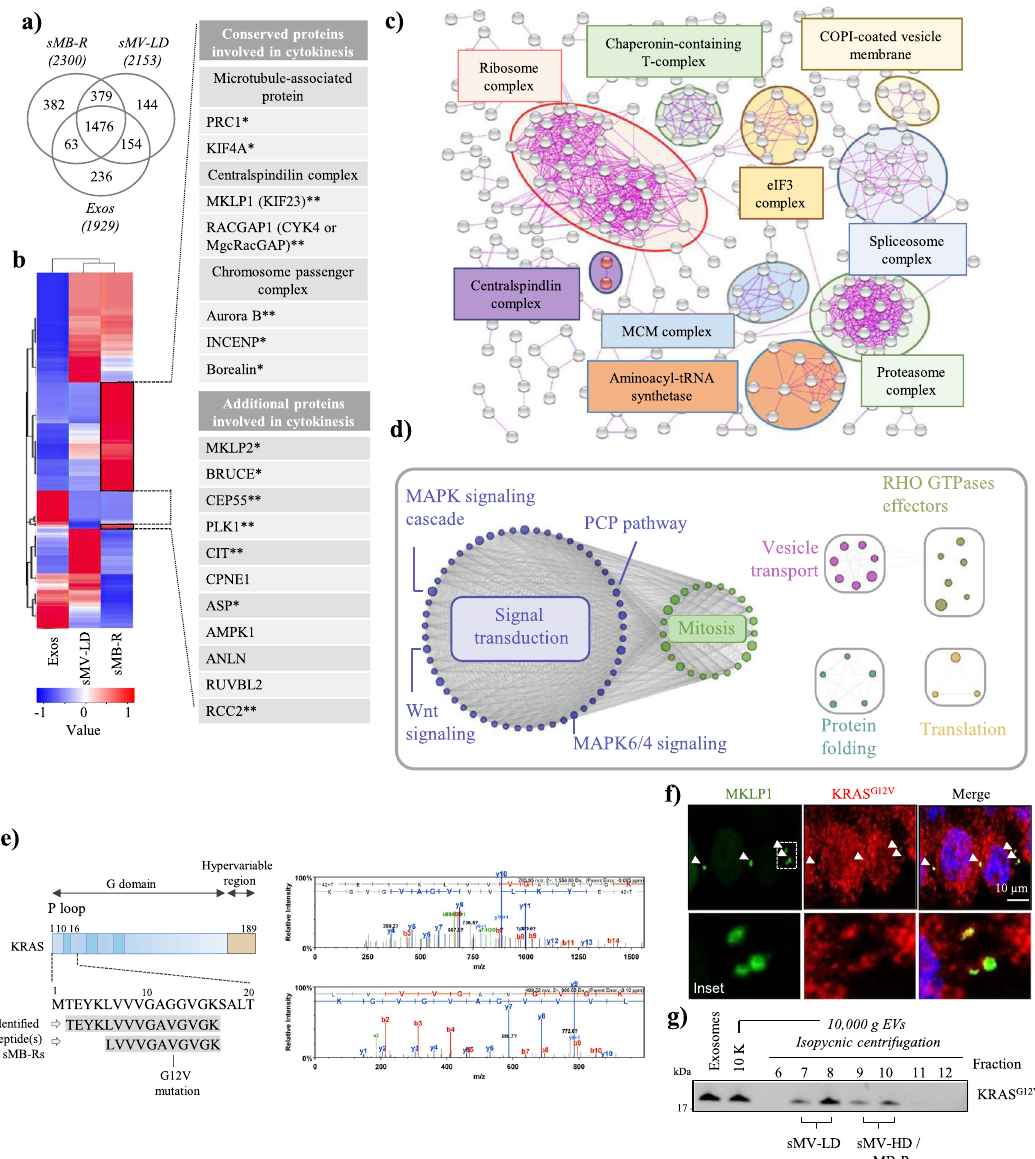
Fig. 3 Proteome analysis of shed midbody remnants. a Venn diagram of proteins identi fi ed in SW620 cell-derived sMB-R (sMV-HD), sMV-LD and Exos. b Heatmap illustration of proteins identi fi ed in sMB-R (sMV-HD), sMV-LD and Exos. Proteins present in higher abundance in sMB-R (red) as compared to sMV-LD and Exos include conserved cytokinetic proteins as well as additional cytokinetic proteins. *Proteins uniquely identi fi ed in sMB-Rs. **Proteins enriched (fold change >2) in sMB-R compared to sMV-LD and Exos. c STRING-based protein-protein interaction network analysis of 928 enriched proteins in sMB-Rs (sMV-HD) compared to sMV-LD and Exos. The interactions were “ evidence ” -based, with “ experiments ” as active interaction source and interaction threshold set at 0.900 (highest con fi dence). Disconnected nodes in the network are hidden. Proteins identi fi ed under biological processes or molecular processes (Gene Ontology) are indicated. Centralspindlin complex components (RACGAP1 and KIF23/MKLP1) are also indicated. d EnrichmentMap of Reactome pathways enriched in 456 proteins commonly identi fi ed in SW620 cell-derived sMB-R proteome (2300 proteins) with the proteome of MB-Rs shed by Hela cells reported recently by Peterman et al. 2019 20 . e Mass spectrometry-based identi fi cation of KRAS peptides (UniProtKB ID RASK_HUMAN) in sMB-Rs. Two peptides (TEYKLVVVGAGGVGK and LVVVGAGGVGK) spanning Gly-12/ Val-12 substitution in KRAS protein. Peptide spectral pro fi les are displayed on the right. f Immuno fl uorescence microscopy of SW620 cells using anti-MKLP1 and anti-KRAS G12V antibodies. Nuclei (blue) were stained with Hoechst stain. White arrows indicate the position of MB and MB-Rs. Inset represents higher magni fi cation. Scale bar, 10 µ m. g Western blot analysis of exosomes, crude 10,000x g sMVs, and isopycnic (iodixanol-density) gradient centrifugation fractions of sMV-LD and -HD/ sMB-Rs using anti-KRAS G12V